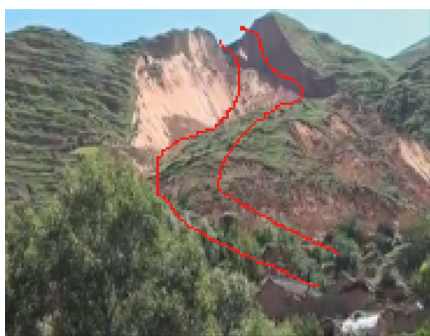
Figure 1: Loess landslide induced by the Min-Zhang Ms 6.6